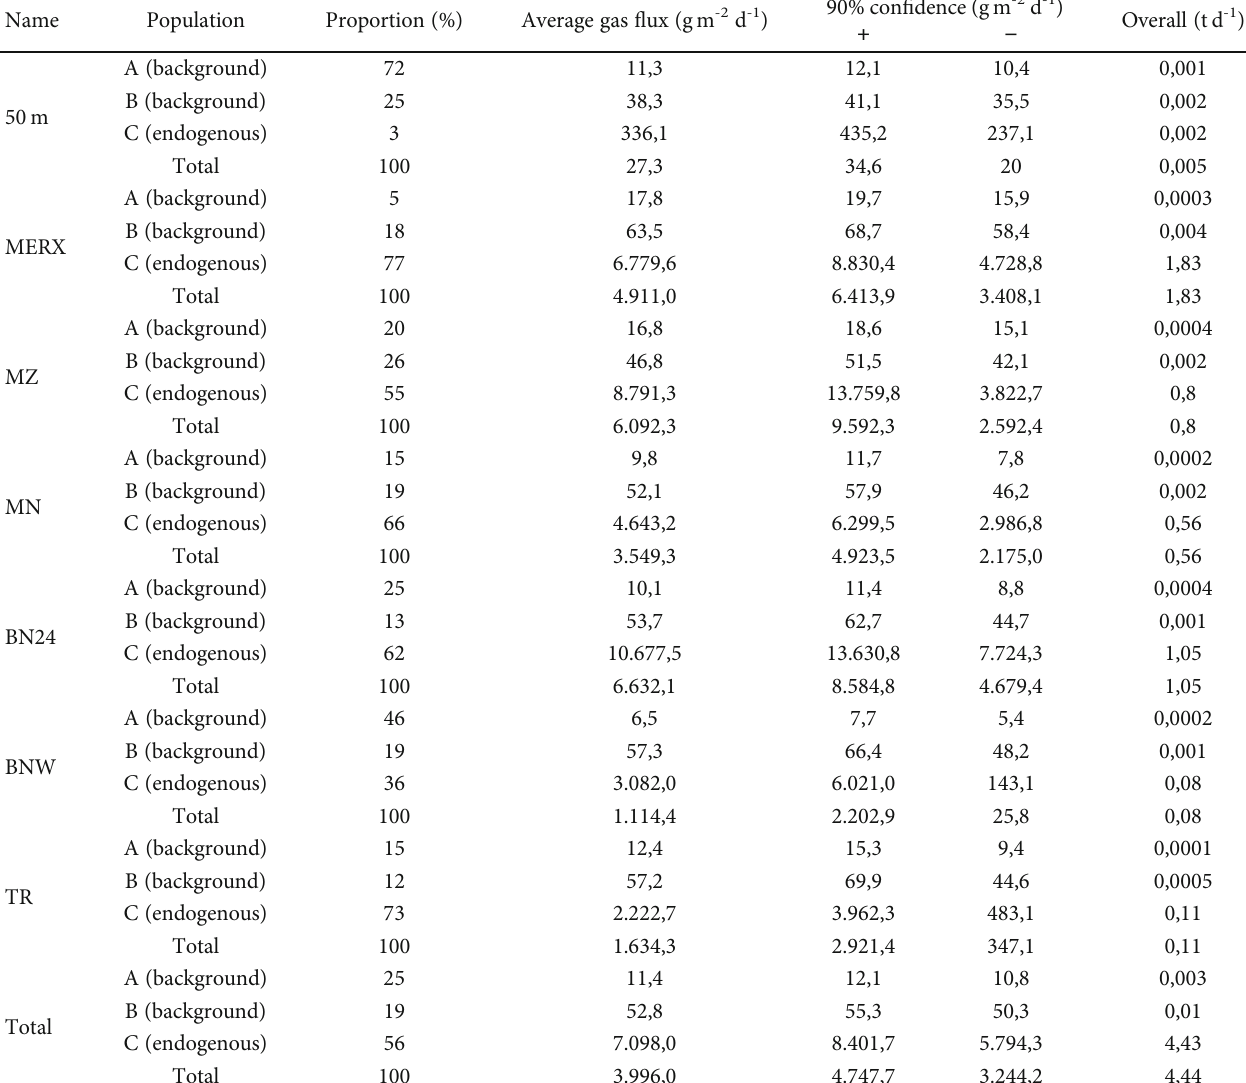
Table 5: Estimated parameters and partitioned populations of the measured data in the surveyed